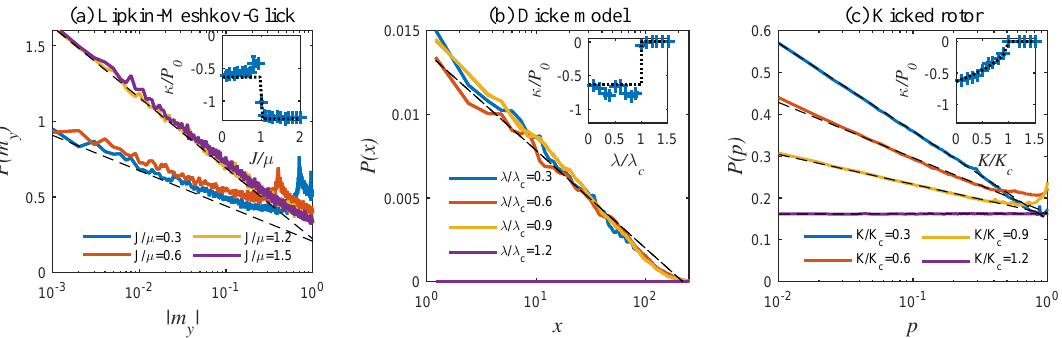
Figure 2: Time-averaged probability distribution function of physical observables for three different models: numerics (continuous curves) and logarithmic fits (dashed lines). In all three model the distribution function diverges logarithmically close to the fixed points of the classical dynamics. Inset: The prefactor of the logarithmic divergence, κ , shows a non-analytic behavior at phase transitions and at the onset of